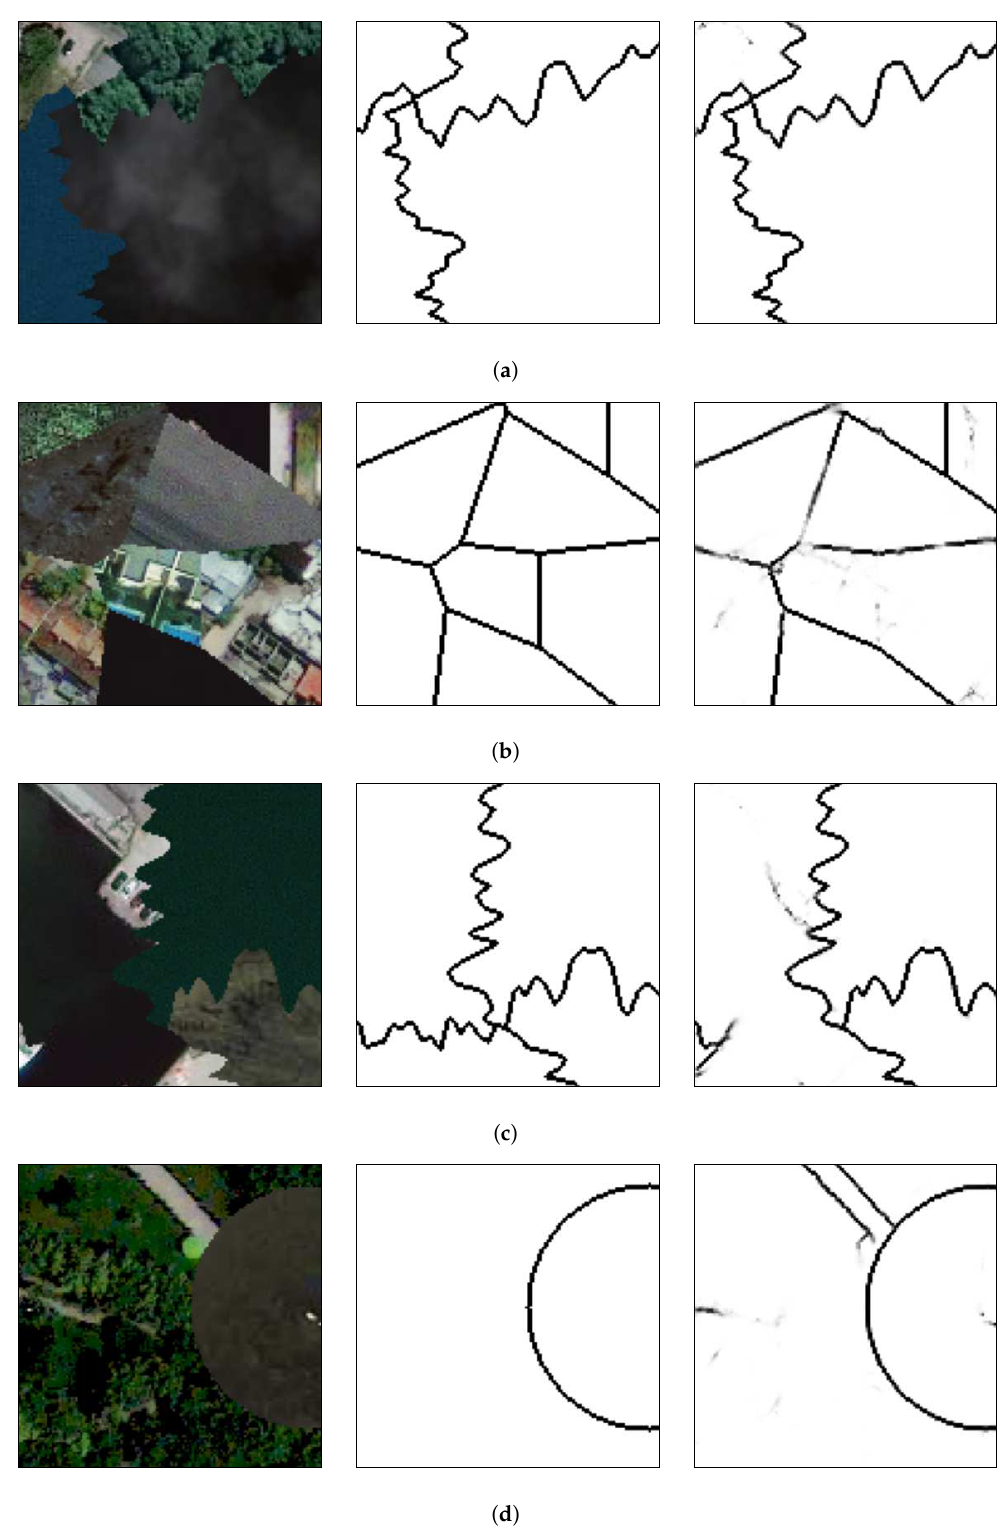
Figure 18. Application on remote sensing images. From left to right, respectively: original image; ground-truth; and the results on the proposed method. Letters ( a – d ) present different mosaic images and are used for referencing the images in the